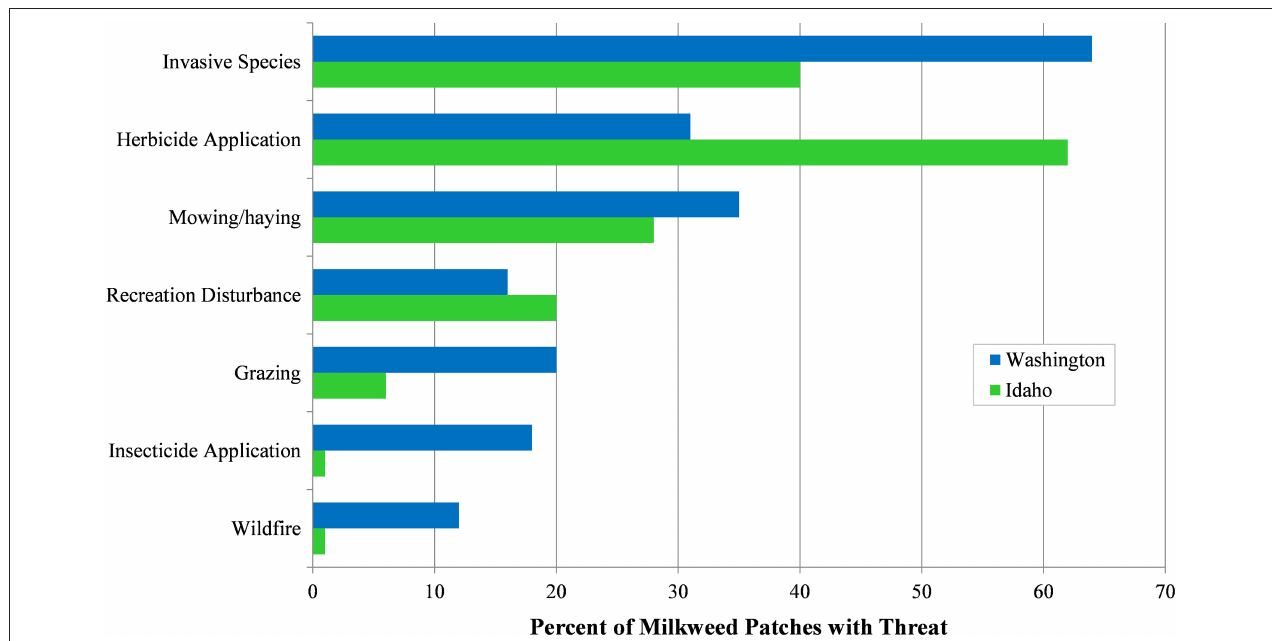
FIGURE 9 | Threat factors identified at milkweed patches ( n = 808) in Idaho and Washington, 2016–2017. Observers could multi-select from 11 threat categories at each